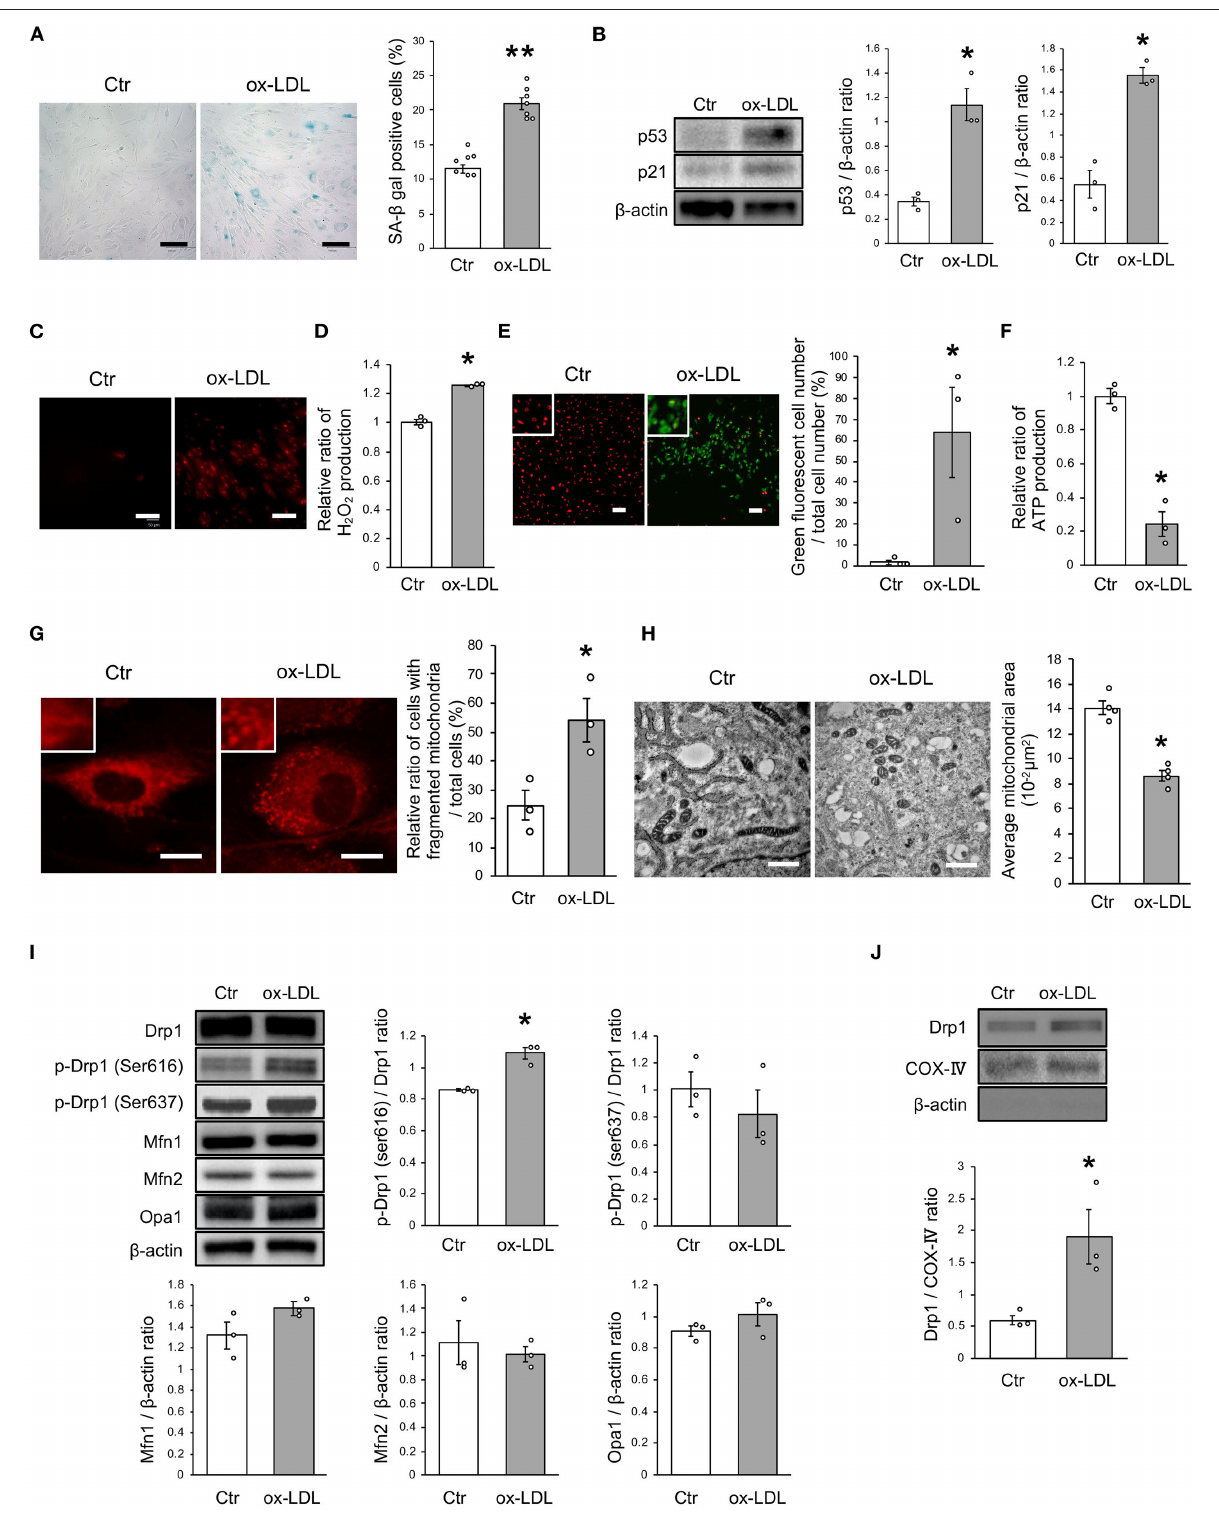
FIGURE 1 | Ox-LDL treatment induced mitochondrial fission, ROS production, mitochondrial dysfunction, and cellular senescence. (A) Representative images and quantitative analysis of SA- β gal staining of cells treated with ox-LDL or the control. Scale bar = 100 µ m. ** P < 0.01 vs. Ctr ( n = 7 per group). (B) Immunoblots